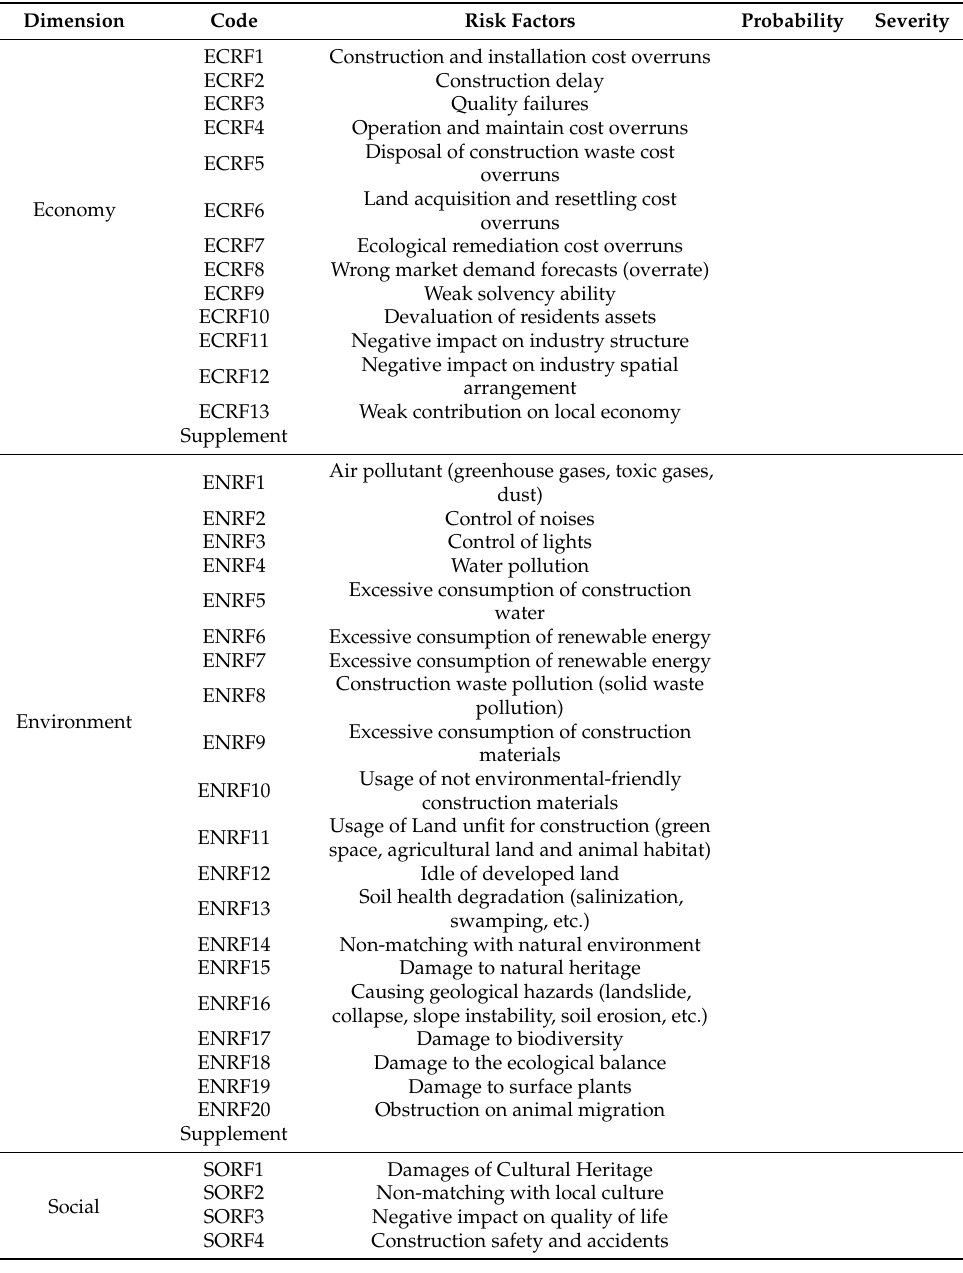
Table A4. Risk factor